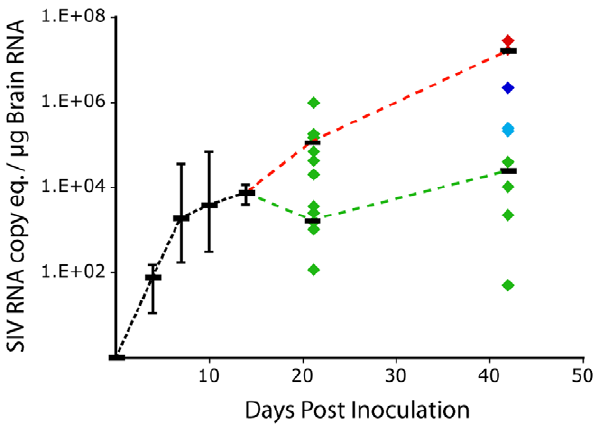
Figure 2. SIV RNA expression in brain of SIV-infected macaques. SIV RNA copies were quantitated by quantitative RT-PCR in RNA isolated from brain collected at each terminal time point from uninfected and SIV-infected macaques (4, 7, 10, 14, 21, or 42 days after inoculation). Medians (black bars) and the range (vertical bars) for each experimental group are indicated. The 21 day group (12 macaques) were split into two groups that had viral RNA levels above or below the median of the 14 day macaques; the median for these two groups are shown. For the 42 day group, each diamond represents one animal, color-coded according to CNS disease severity (red - severe; blue - moderate; turquoise - mild; green–none), and the black bars represent the medians for severe/moderate (red dotted line), and mild/none animals (green dotted line).